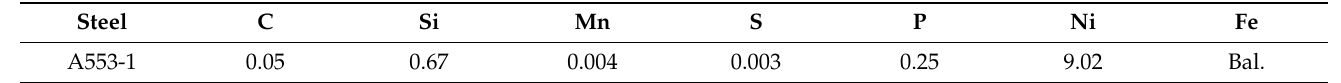
Table 1. Chemical composition of steels used (wt. %).